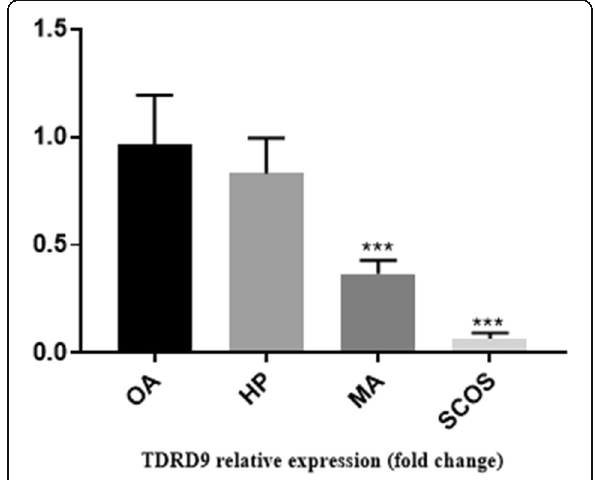
Fig. 4 Comparison of the expression levels of TDRD9 between HP, MA, SCOS, and OA(control) patients. *** p <